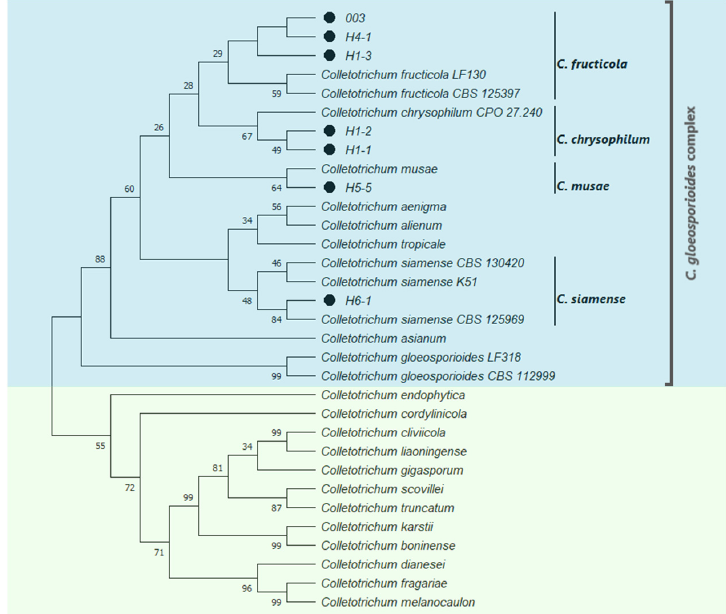
Figure 2. Identification of Colletotrichum species isolated from Mangifera indica L. Bootstrap consensus tree inferred by the maximum likelihood method and general time-reversible model based on the sequences of ITS, Act, β -Tub 2 , GAPDH, CHS-1, CaM, and ApMat. Bootstrap values next to the branches stand for the percentage of replicate trees in which the associated taxa clustered together (1000 replicates). Black dots show isolates characterized in the present